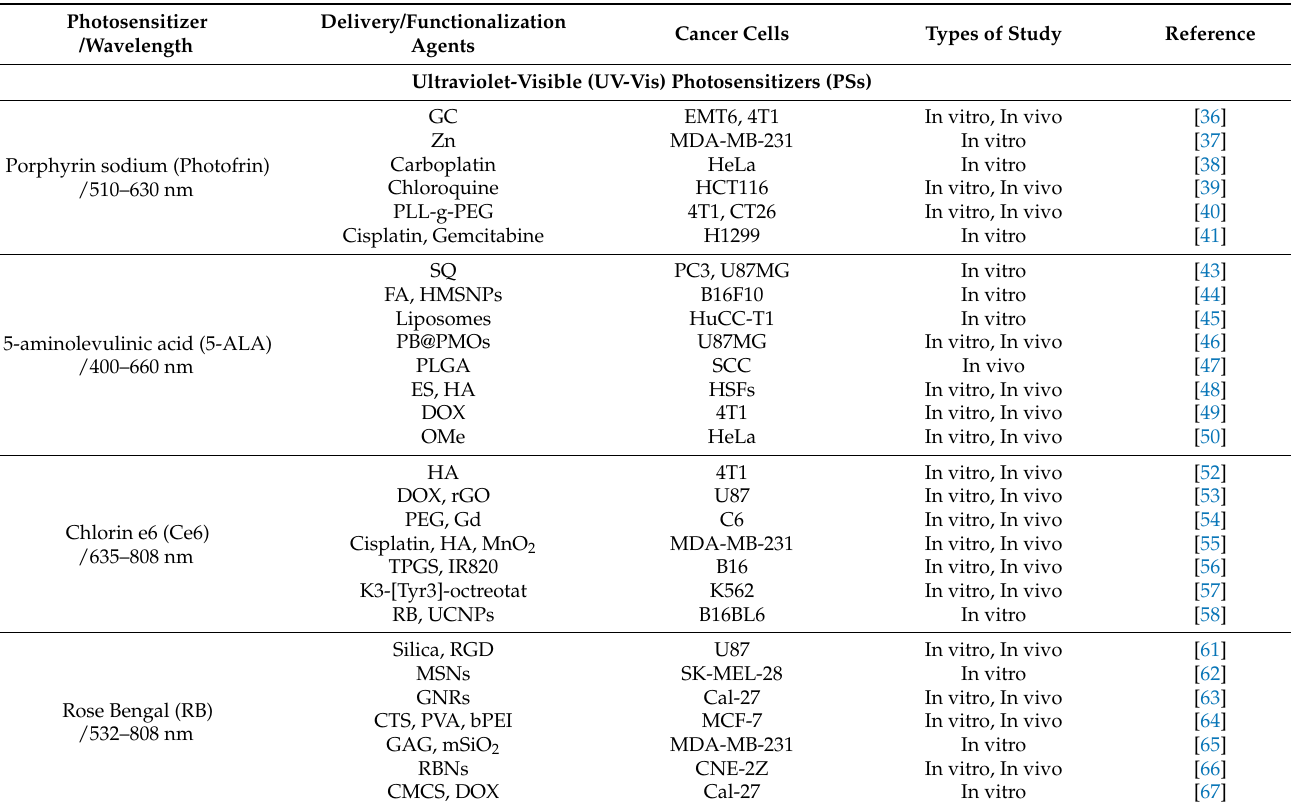
Table 1. Summary of photosensitizer-containing nanocomposites for cancer therapy. Photosensitizer